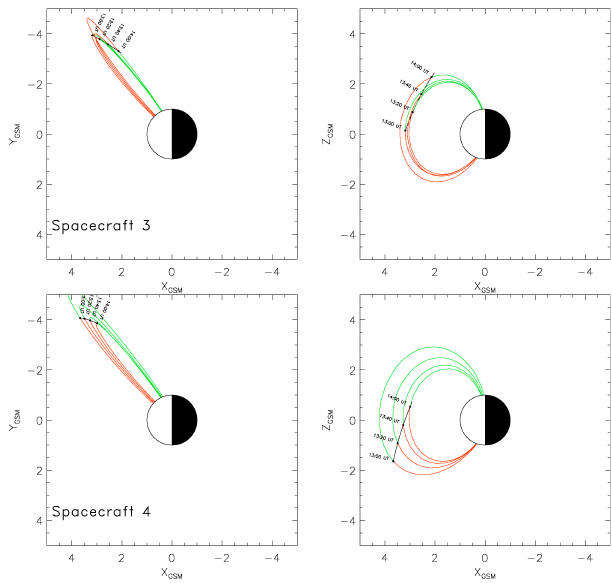
Fig. 2. Cluster 3 (top two panels) and 4 (bottom two panels) orbit. Also shown is the T96 model geomagnetic field with input parame- ters p dyn = 2 . 0nPa, D st = 0 . 0, B y, IMF = 0 . 0nT, B z, IMF = 0 .